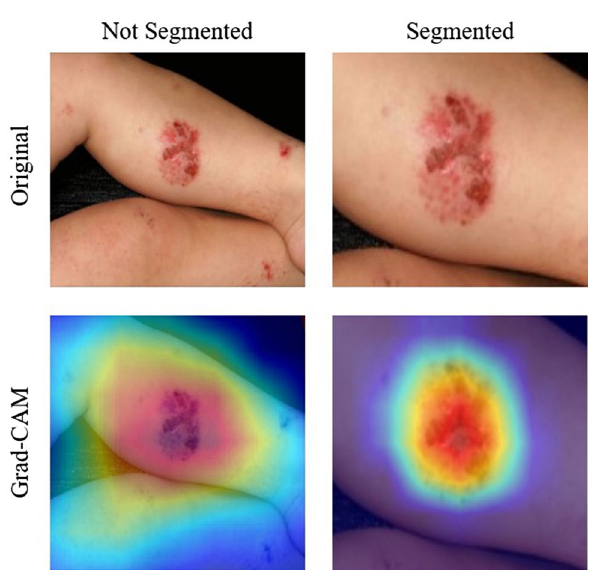
Figure 3. Grad-CAM results for unsegmented and segmented images in our Dermnet dataset. The top row shows the original input images. The left image shows the unsegmented image and the right image shows the segmented image. The bottom row shows the result of Grad-CAM 11 . The left image of Grad-CAM for the unsegmented image shows that the EfficientNet model focused on a larger surface other than erythema. The right image of Grad-CAM for the segmented image shows than that the EfficientNet model correctly focused mostly on